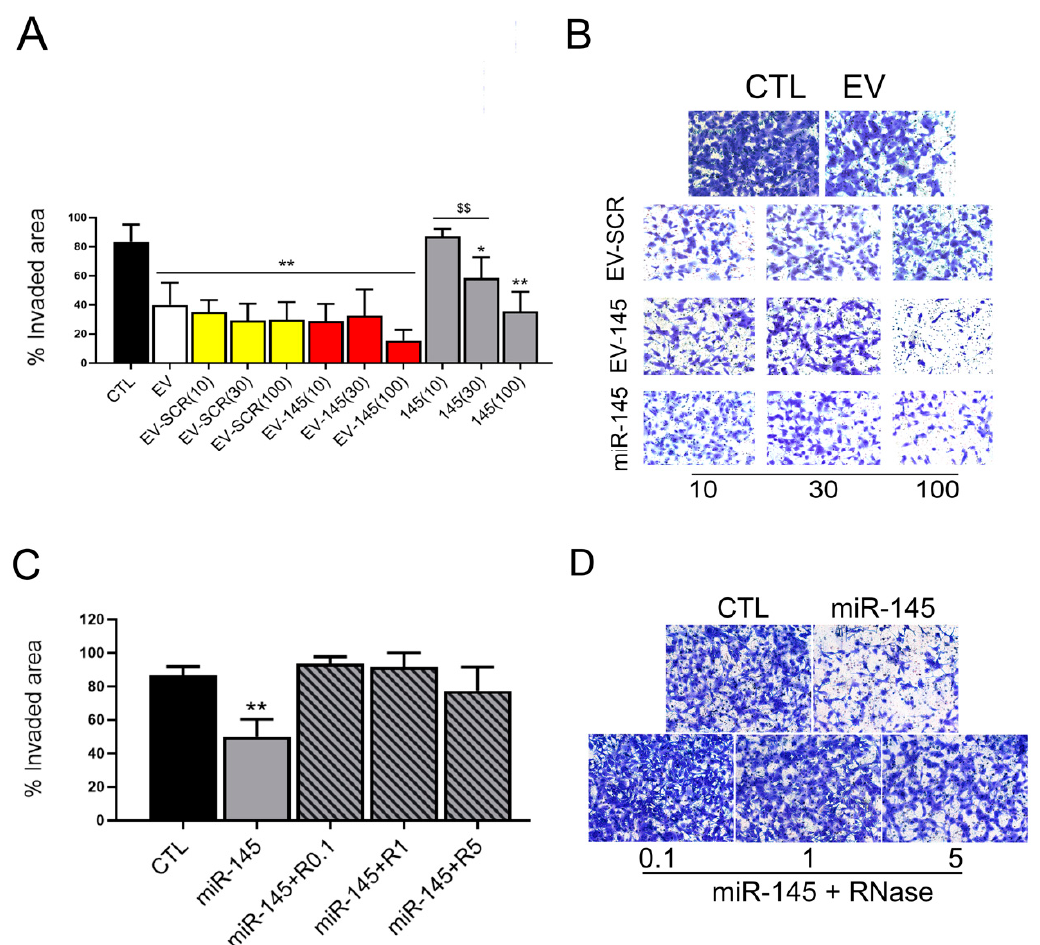
Figure 1. Effect of miR145 coincubated HLSC-EVs on rCSC invasion. ( A , B ) Quantification ( A ) and representative micrographs (original magnification: 100×) ( B ) of rCSCs invasion after treatment for 48 h with HLSC-EVs (EV) loaded with different doses (100/30/10 pmol/10 10 EVs, corresponding to 6000/2000/600 molecules/EV) of a scrambled sequence (EV-SCR) or with miR-145 (EV-145), or miR-145 alone (145); all at a dose of 10, 30 or 100 pmol/10 10 EVs. Data are represented as mean ± SD of the percentage of invaded area of three experiments. * = p < 0.05 and ** = p < 0.001 vs. CTL; $$ = p < 0.001 vs. 145(100). ( C , D ) Invasion assay quantification ( D ) and representative micrographs (original magnification: 100×) ( E ) of rCSCs treated for 48 h with miR-145 untreated (miR-145) or digested with 0.1, 1 or 5 ng/µL of RNase-A (miR-145 + R0.1, 1 or 5, respectively). Data are represented as mean ± SD of the percentage of the invaded area of the three experiments. ** = p < 0.001 vs. CTL.